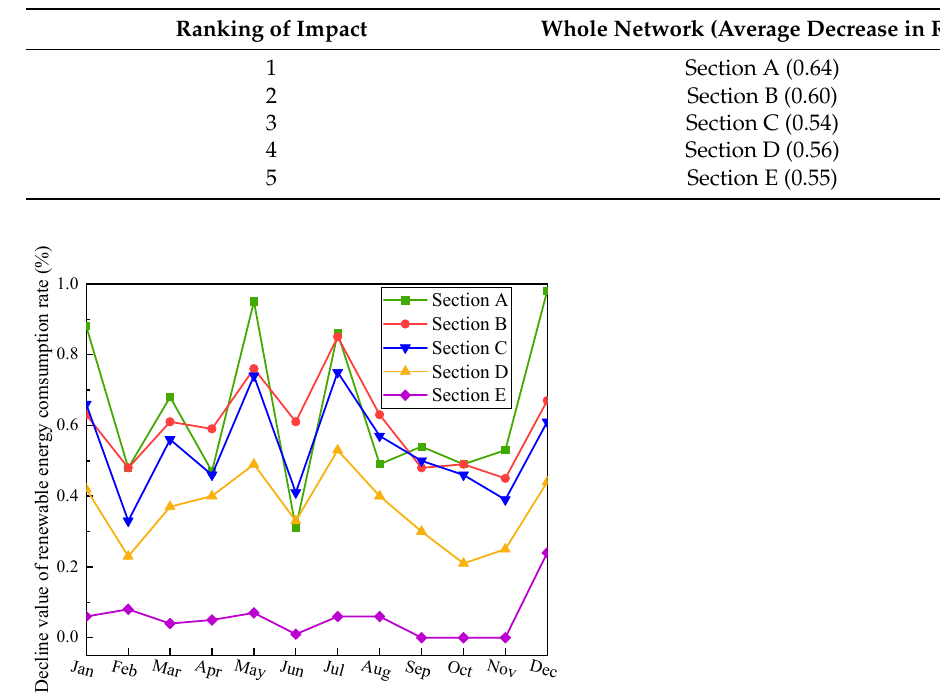
Table 4. Decrease in the value of the renewable energy consumption rate in the whole network and in each section (%).